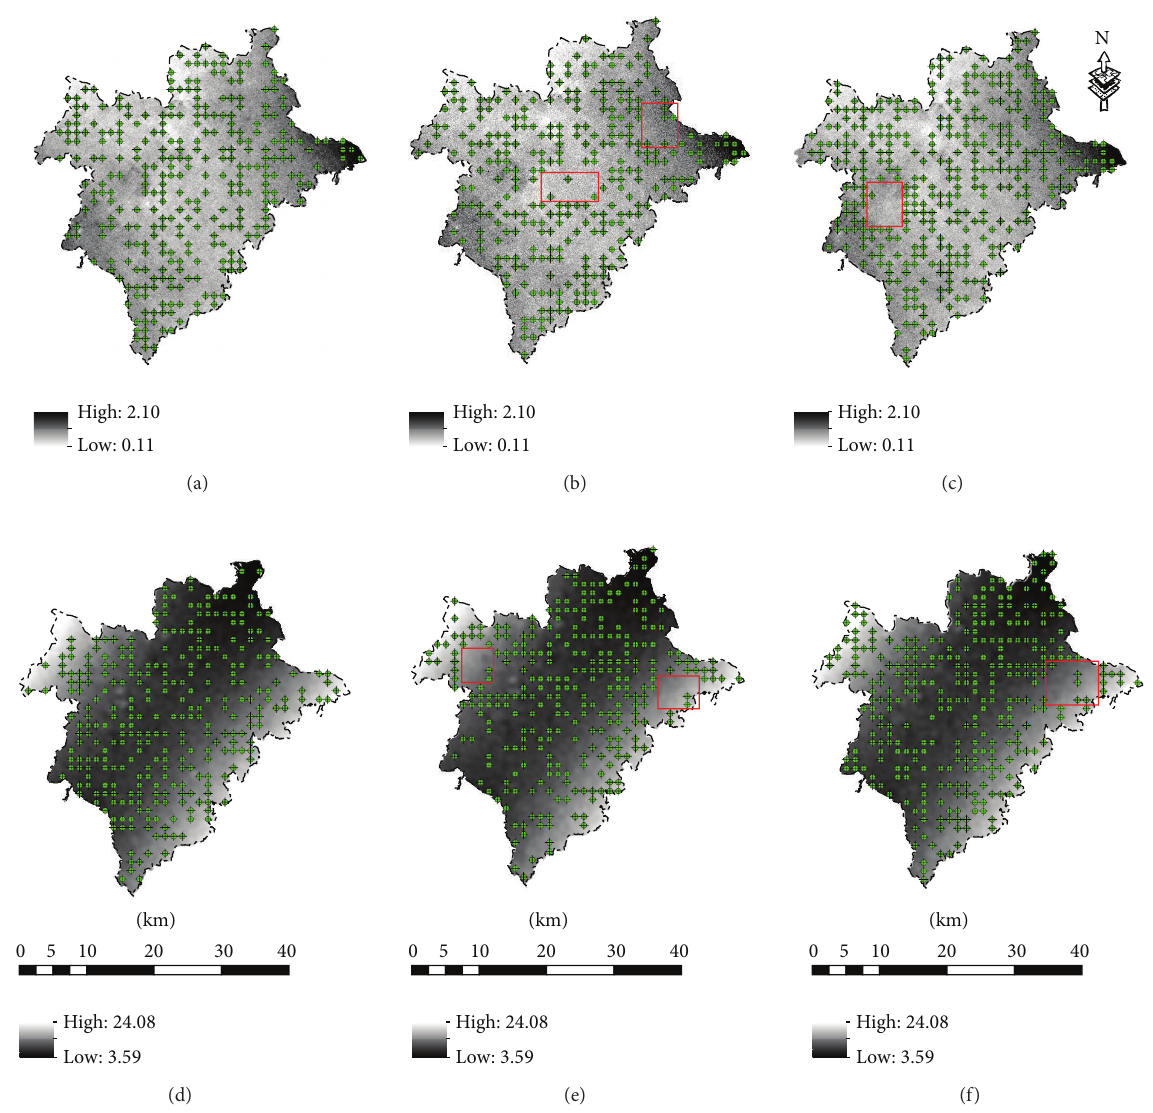
Figure 4: The optimal soil monitoring networks of SOM and SWC. (a) MKE + MSB, (b) MKE and (c) MSB for SOM, and (d) MKE + MSB, (e) MKE, and (f) MSB for SWC, of which backgrounds depict the related realizations map of SOM and SWC simulated by a sequential Gaussian simulation